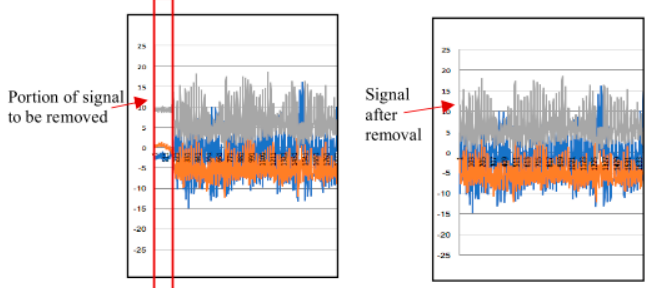
Figure 2. Signal manual cleansing. The values in the y -axis correspond to acceleration in m / s 2 . The x -axis shows the evolution of the observations. Each second, 51.2 acceleration data are gathered by the shimmer. This means the value of 100 in x -axis correspond to the time 1.95 s. The blue, orange, and grey lines represent the acceleration in x -, y - and z -axis.